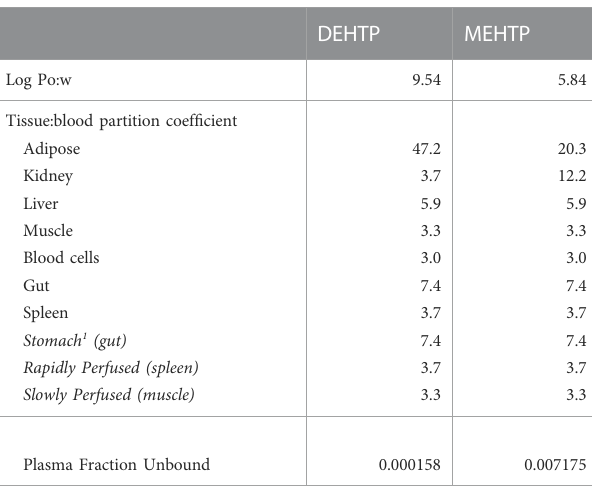
TABLE 1 Tissue:blood partition coef fi cients and plasma fraction unbound predicted using Log P ow .